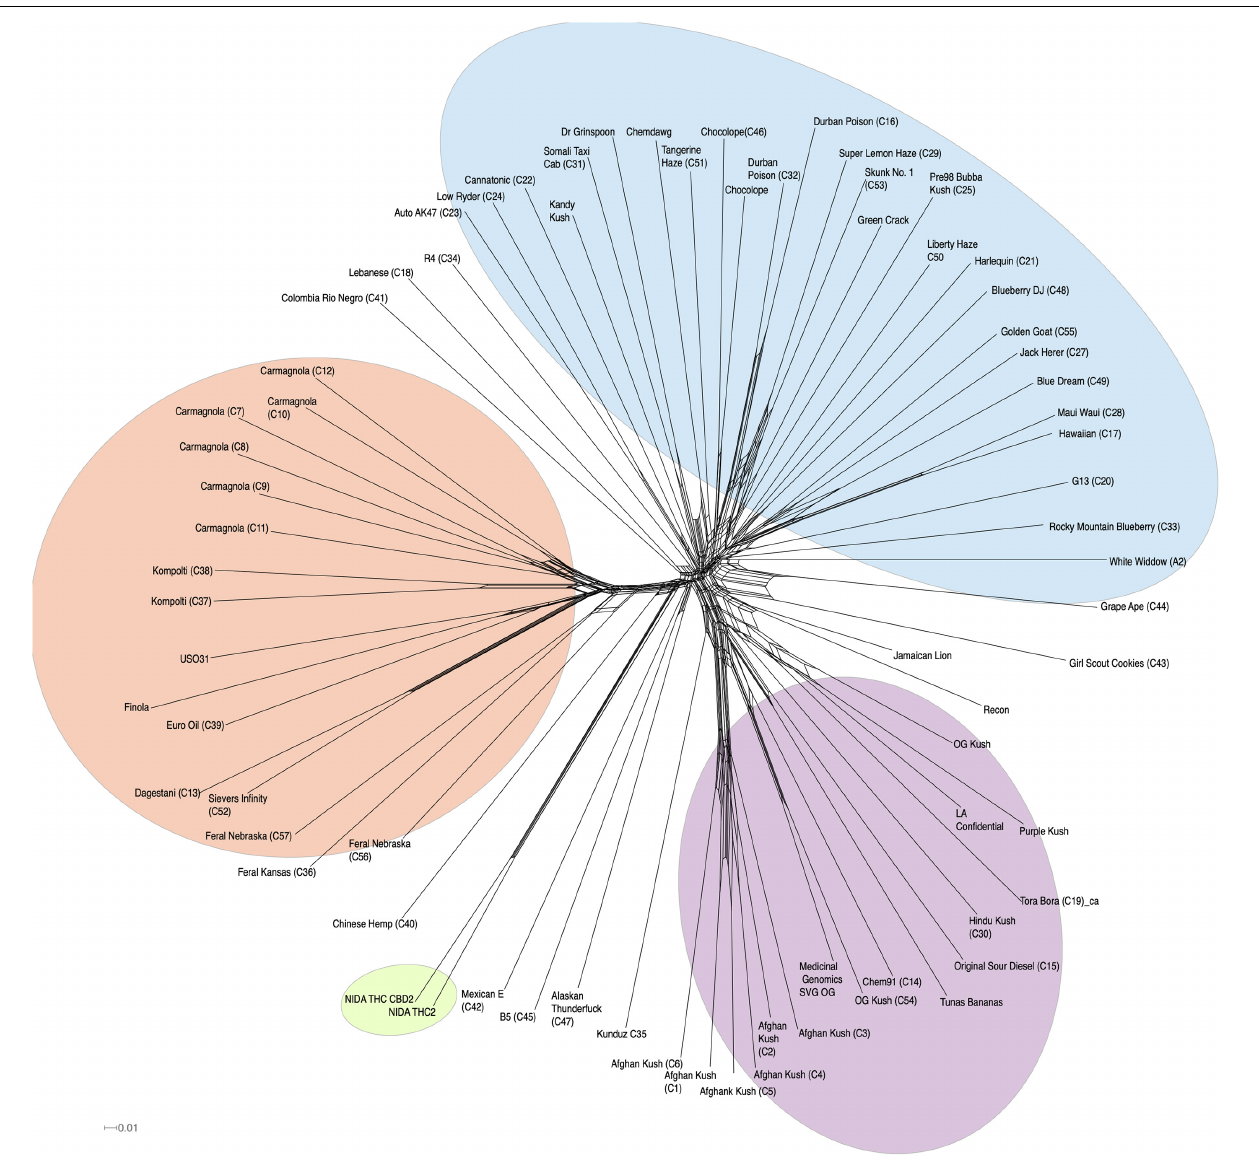
FIGURE 2 | SplitsTree graph. Genetically similar individuals cluster together, such as the NIDA cluster, “Afghan Kush” cluster, and “Carmagnola” cluster. NIDA samples are highlighted in green. Hemp, NLMT, and BLMT shown in orange, blue, and purple, respectively.